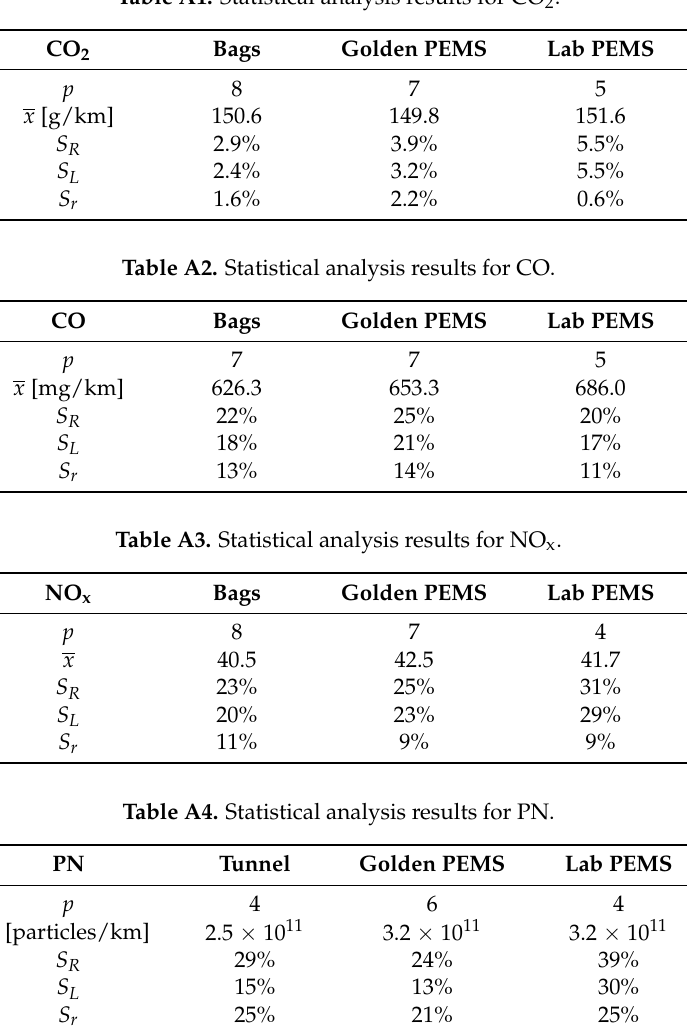
Table A1. Statistical analysis results for CO 2 .